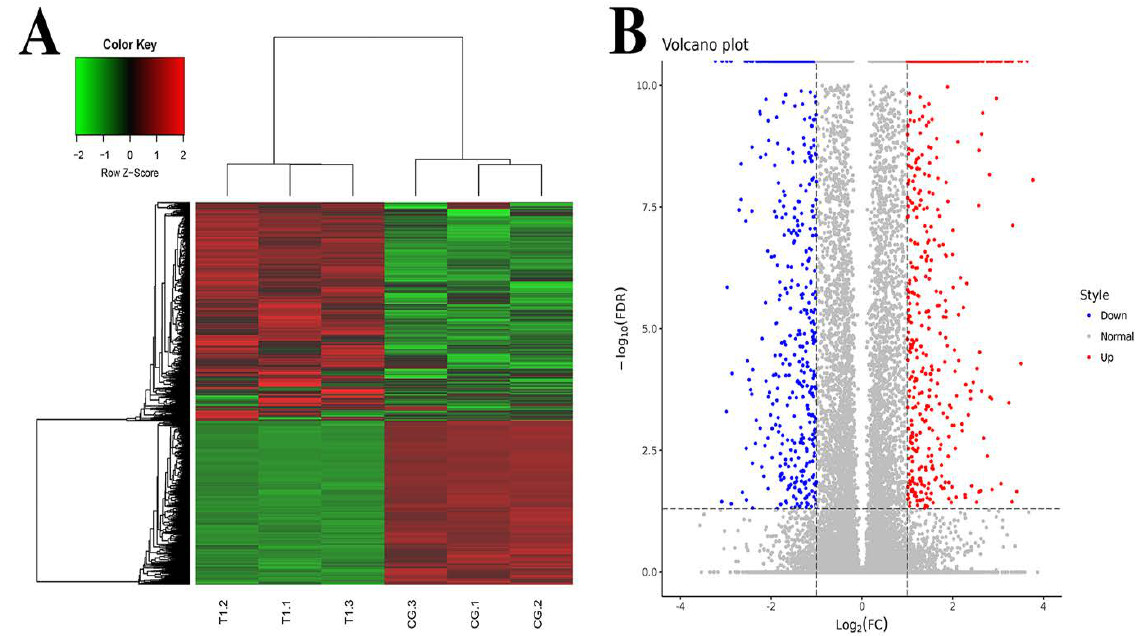
Figure 1. Differentially expressed genes analysis. ( A ) Clustering of differentially expressed genes. Hierarchical clustering is based on FPKMs, where log 10 (FPKM + 1) is used for clustering. The red color represents genes with higher expression, while the green color represents genes with lower expression. ( B ) Volcano plot of differential expression gene. Red represents genes with higher expression; blue represents genes with lower expression. CG, control group, milk duct perfusion with 6 mg/kg normal saline. T, tea polyphenols group, milk duct perfusion 6 mg/kg tea polyphenols.